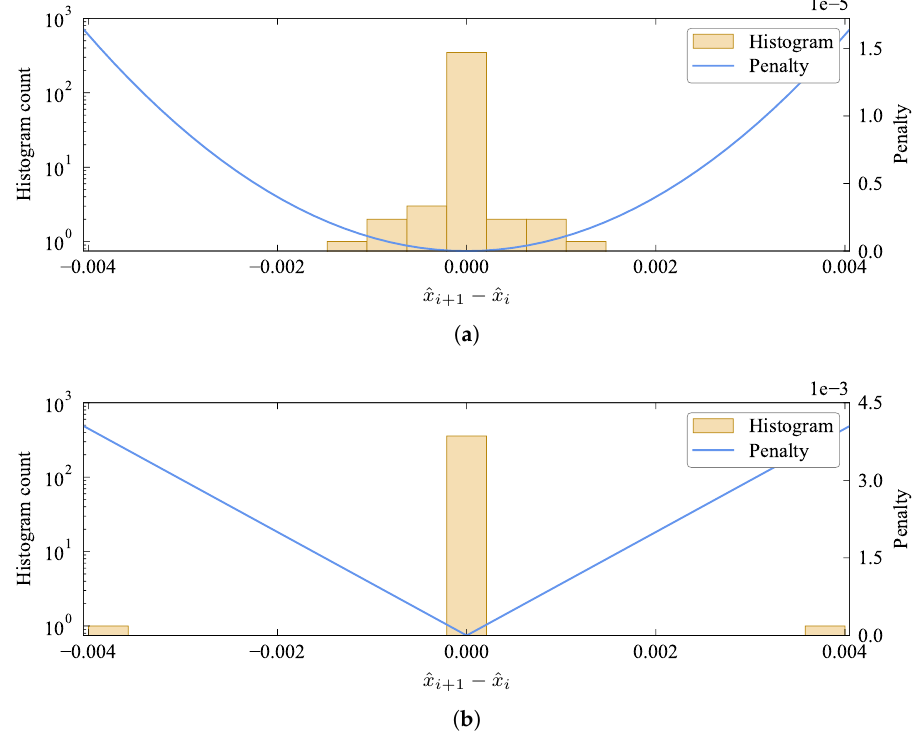
Figure 11. Histogram of the first derivative amplitudes for the filtered synthetic signal 1 using the optimal δ value for each scenario. ( a ) Quadratic smoothing with δ = 2. ( b ) Total variation smoothing with δ =